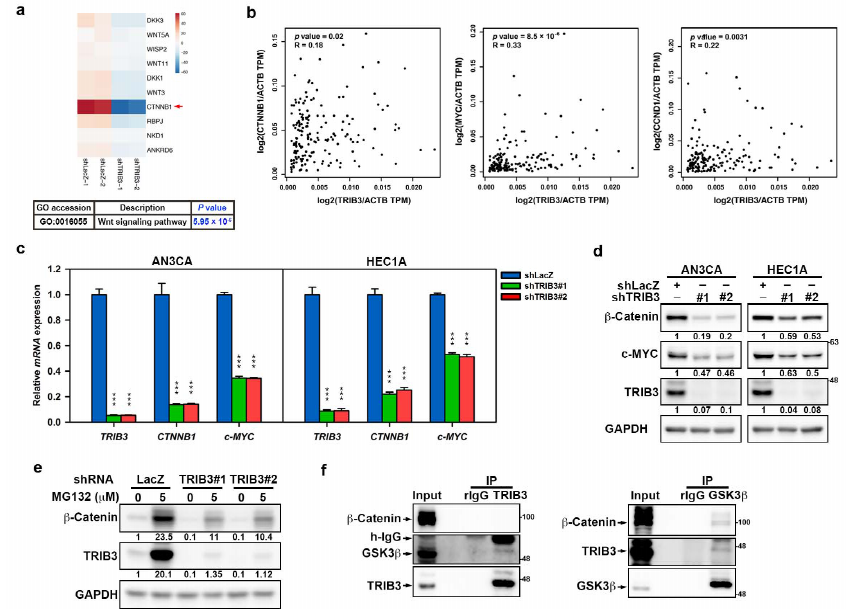
Figure 5. β -catenin expression in EC cells was regulated by TRIB3 in transcriptional and translational mechanisms. ( a ) HEC1A cells were transduced with shLacZ and TRIB3-specific shRNA (#1) carrying lentiviruses and selected with 2 µ g / mL puromycin for 3 days followed by RNA-seq analysis in duplicate. The upper panel shows the genes downregulated in HEC1A cells with TRIB3 knockdown significantly enriched in the WNT signaling pathway. Heat map of the WNT / β -catenin signal-associated genes altered in TRIB3-knockdown HEC1A cells compared to shLacZ group. CTNNB1 is highlighted with a red arrow (lower panel). ( b ) Pearson’s correlation analysis of TRIB3 and CTNNB1 (left panel), as well as β -catenin downstream genes, c-MYC (middle panel) and CCND1 (right panel), in UCEC patients were analyzed and plotted using the GEPIA website (http: // gepia.cancer-pku.cn / index.html). ( c , d ) AN3CA (left panel) or HEC1A (right panel) cells were transduced with lentiviruses carrying with shLacZ (blue) or TRIB3-specific shRNAs (#1, green; #2, red) for 3 days. The relative mRNA levels of TRIB3 , c-MYC , and CTNNB1 were determined by SYBR-Green-based qRT-PCR ( c ). Data are presented as fold changes (mean ± SD) relative to shLacZ from three individual experiments. *** p < 0.001 when compared to shLacZ. ( d ) Specific amounts (25) µ g of total cellular proteins were used for determination of β -catenin, c-Myc, or TRIB3 expression by Western blot analysis. ( e ) shRNA transduced AN3CA cells were treated with 5 µ M of MG-132 for 24 h, and 25 µ g of total cellular proteins were harvested for analyzing the expression of TRIB3 and β -catenin by Western blot. ( f ) Specific amounts (0.5 mg) of total cellular proteins from AN3CA cells were used for immunoprecipitation with an anti-TRIB3 antibody or control IgG following by the detection of β -catenin and GSK3 β in pull-down proteins by Western blot (left panel). Whole-cell extracts from AN3CA cells were immunoprecipitated with anti-GSK3b antibody or rabbit IgG and blotted with anti- β -catenin and anti-TRIB3 antibodies (right